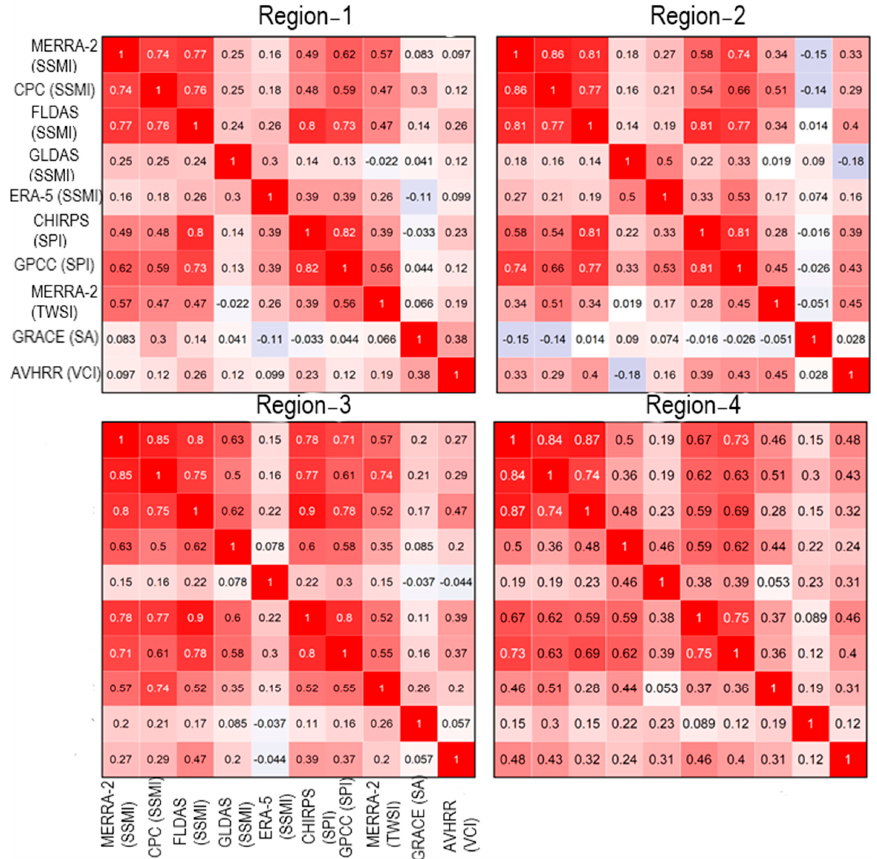
Figure 6. Relationships between drought indices for all four regions of South Asia. Significant ( p < 0.05) correlations between drought indices (MERRA-2, CPC, FLDAS, CHIRPS, and GPCC) have been observed in regions two and three, which supports the